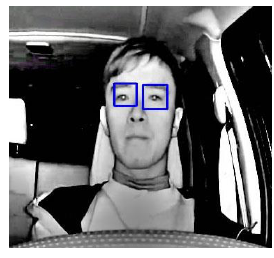
Figure 3. Detection and tracking of the driver’s eyes.